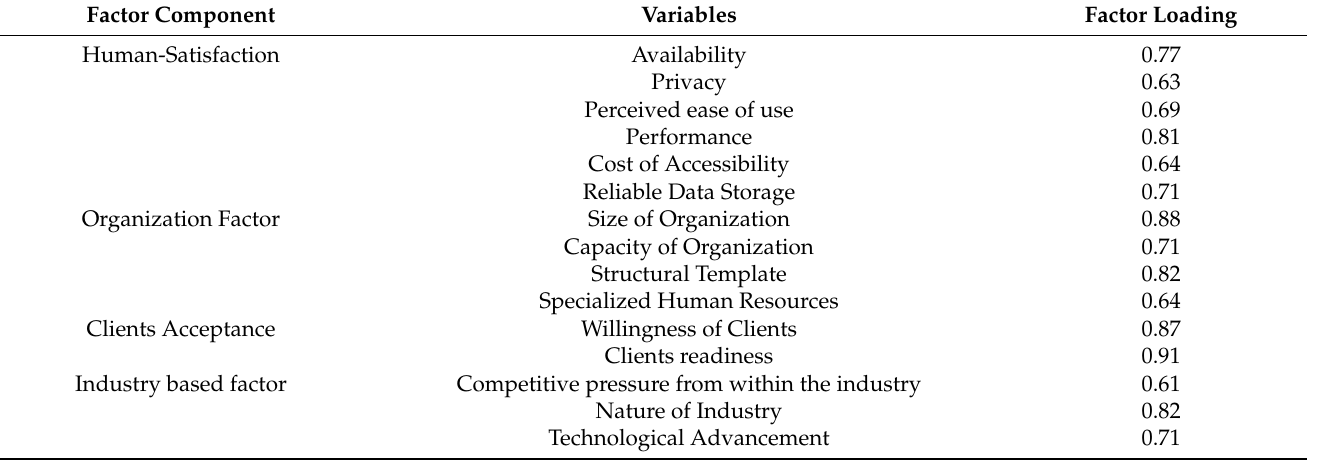
Table 7. Related component of the success factors influencing the adoption of cloud computing in the Nigerian construction